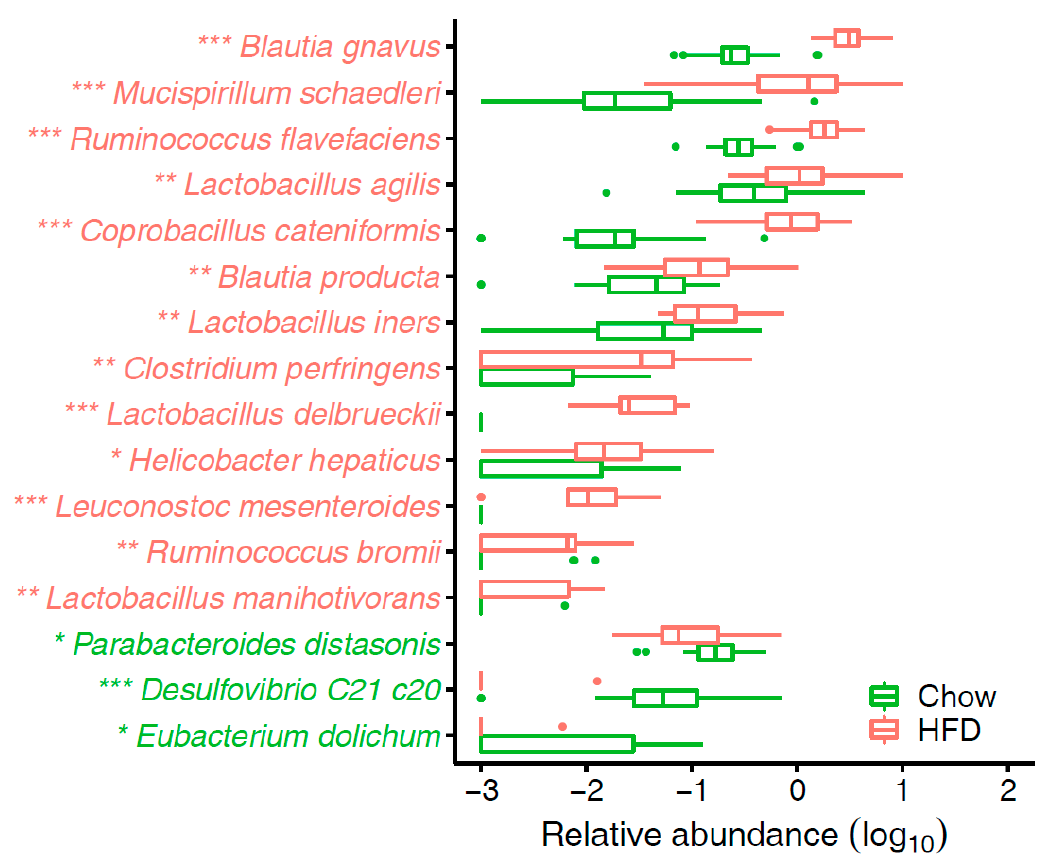
Figure 4. Species that significantly differ in abundance between chow group and HFD group. * FDR < 0.05, ** FDR < 0.01, *** FDR < 0.001, FDR-controlled Wilcoxon rank-sum test. The species names are colored according to significant differences: green, enriched in chow group; red, enriched in HFD group.